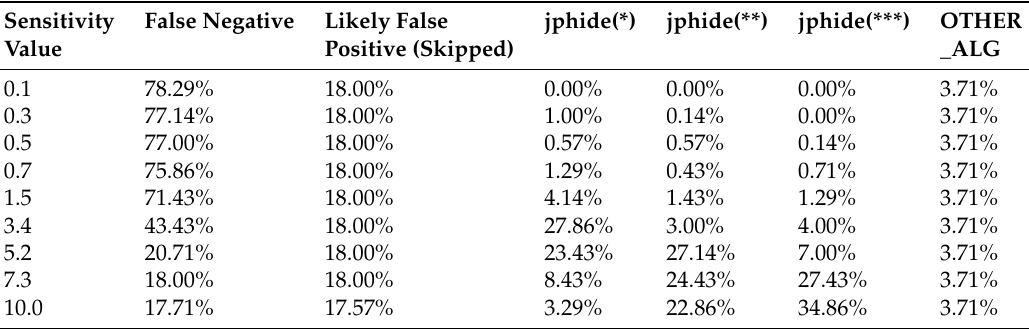
Table 5. Results of 700 images from Washington University image database with different sensitivity values.